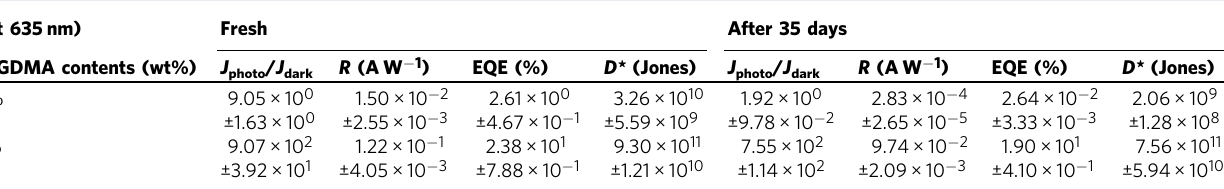
Table 1 Comparison of additional optical response parameters between fresh and after 35 days of Au/ γ -CsPbI 3 (0, and 3 wt% PEGDMA)/Au photoresistors at 40 V.